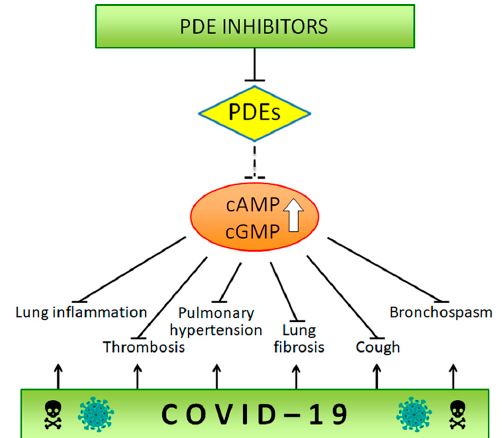
Figure 1. The scheme highlights the different pathologies currently treated with phosphodiesterase inhibitors that are in common with disorders linked to severe acute respiratory syndrome corona virus 2 (SARS-CoV2) infection.